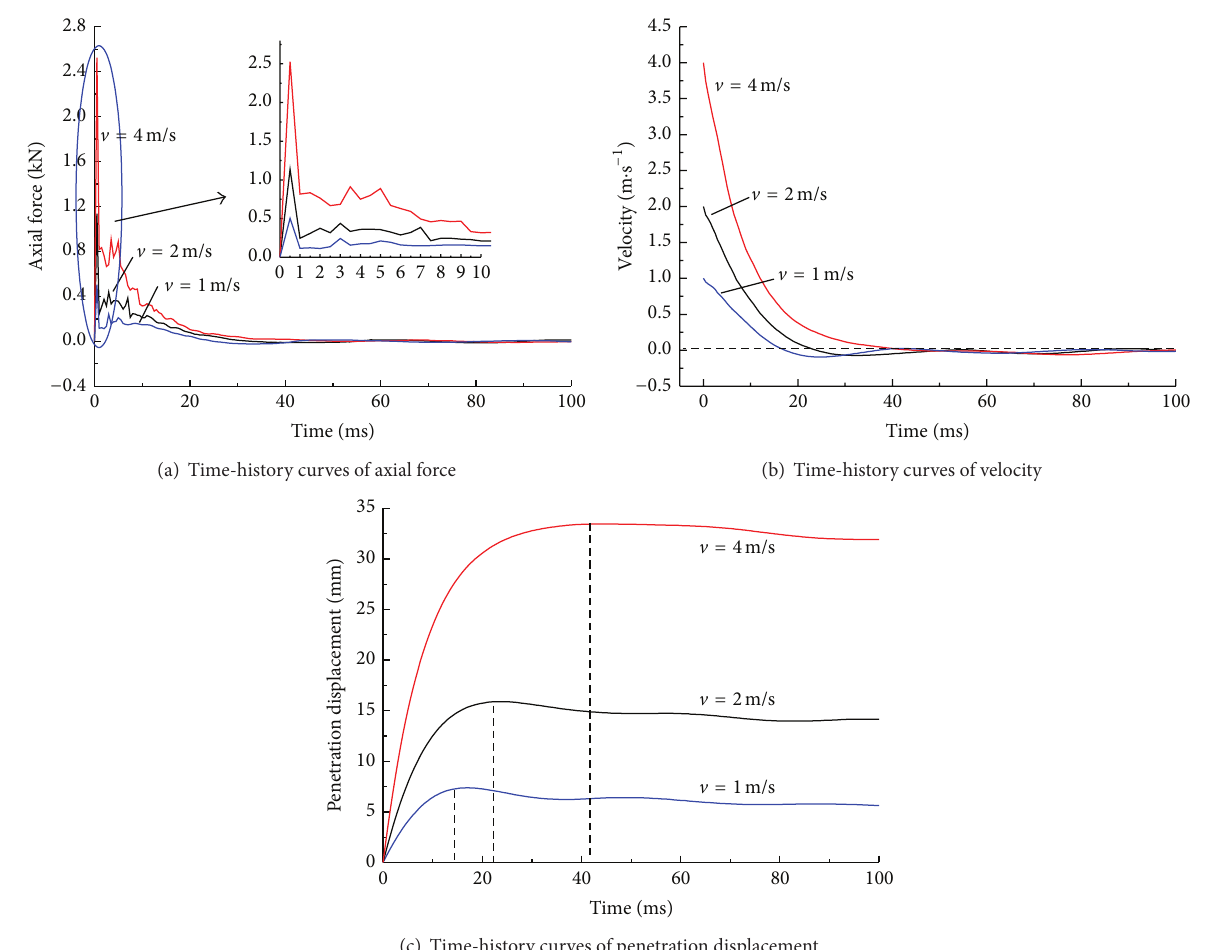
Figure 30: Curves of dynamic response when 𝐷 𝑟 = 60 % and 𝑚 = 3 kg at different impact velocities.